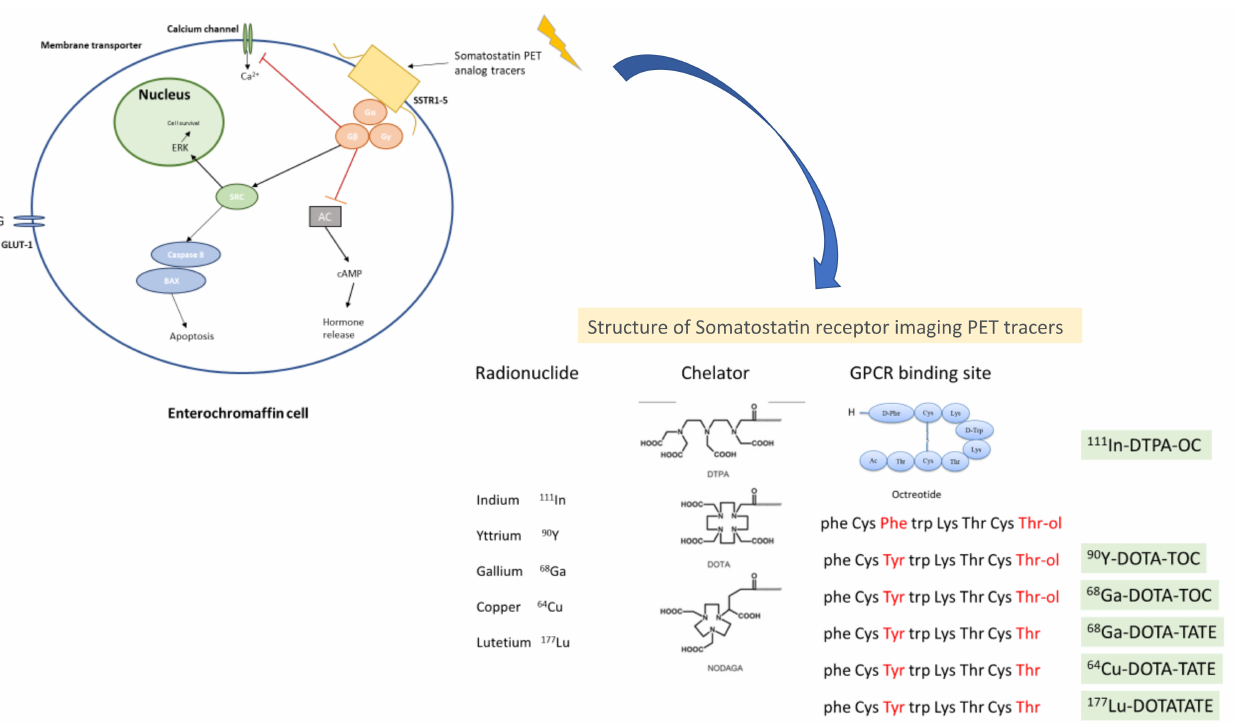
Figure 2. Structure and mechanism of action from somatostatin receptor imaging PET tracers. The Figure explains the basic molecular mechanisms of the endocrine cell and the main receptors used for diagnosis in NEN based on PET imaging. Legend: AC: adenylate cyclase, SSTR1–5: